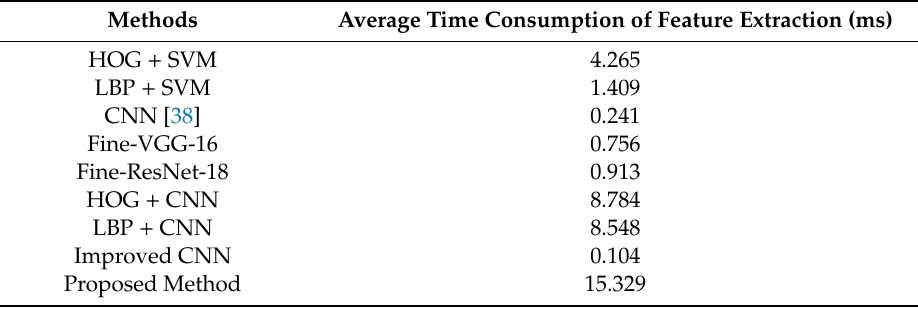
Table 14. The average time consumption of the feature extraction per image for the VAIS dataset.